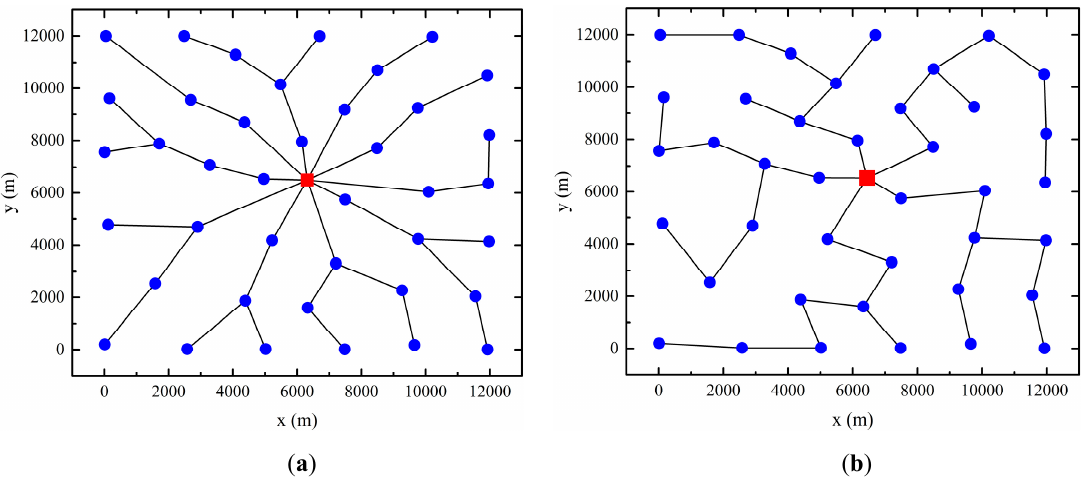
Figure 7. Optimal connection topology generated by ( a ) the integration method and ( b ) the two-step method.